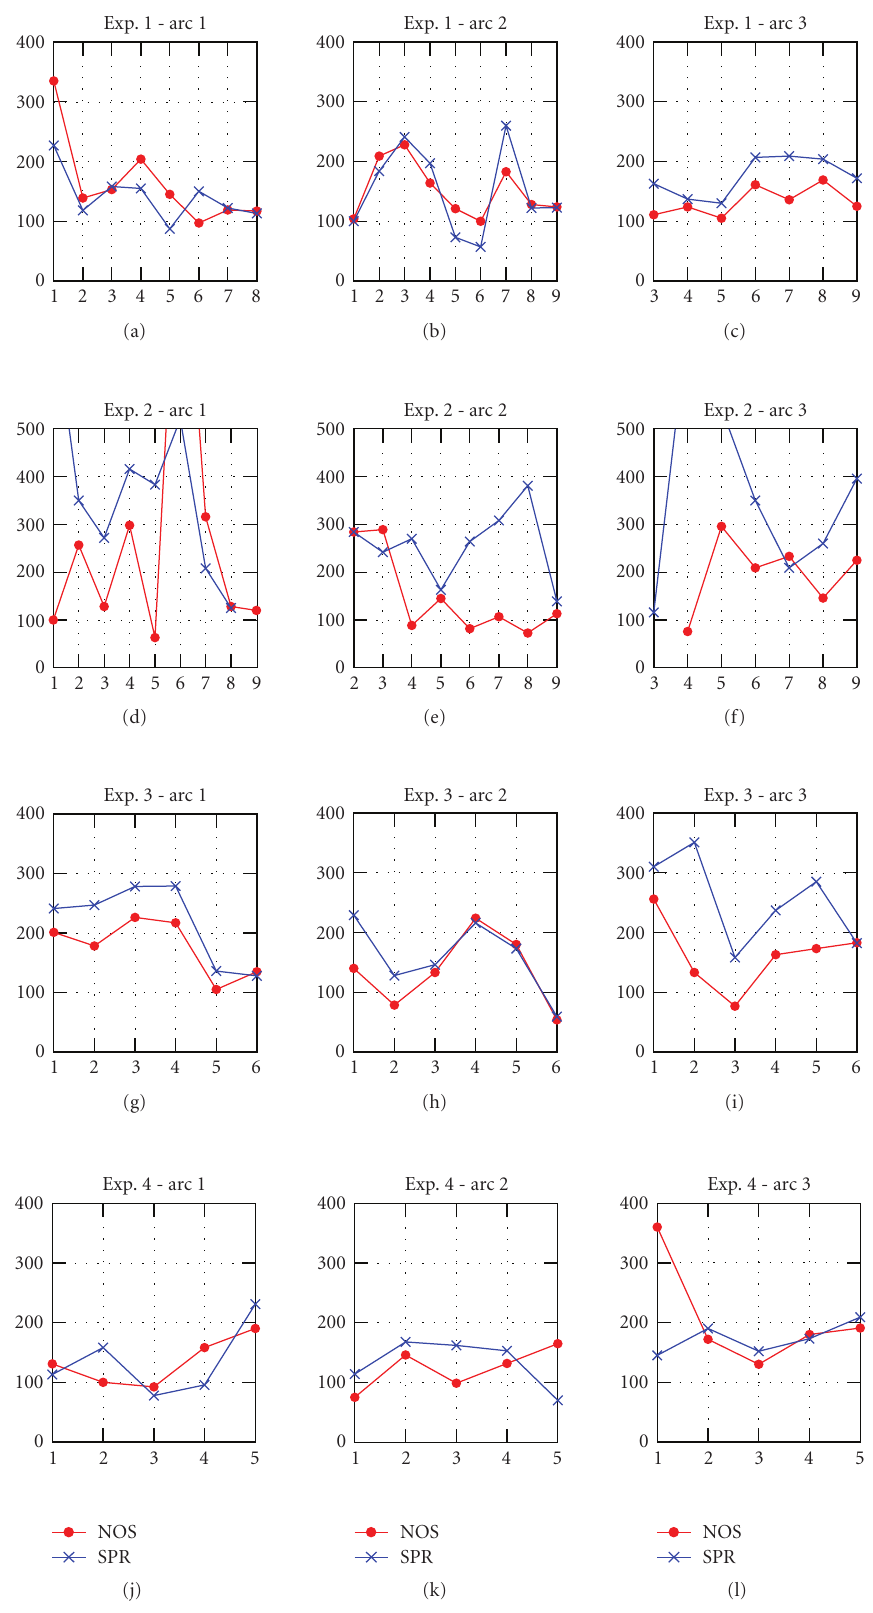
Figure 8: Normalized root mean square errors (expressed as a percentage) according to the experiment, of the arc of measurement points and time (NOS = NOSTRADAMUS code; SPR = MINERVE-SPRAY